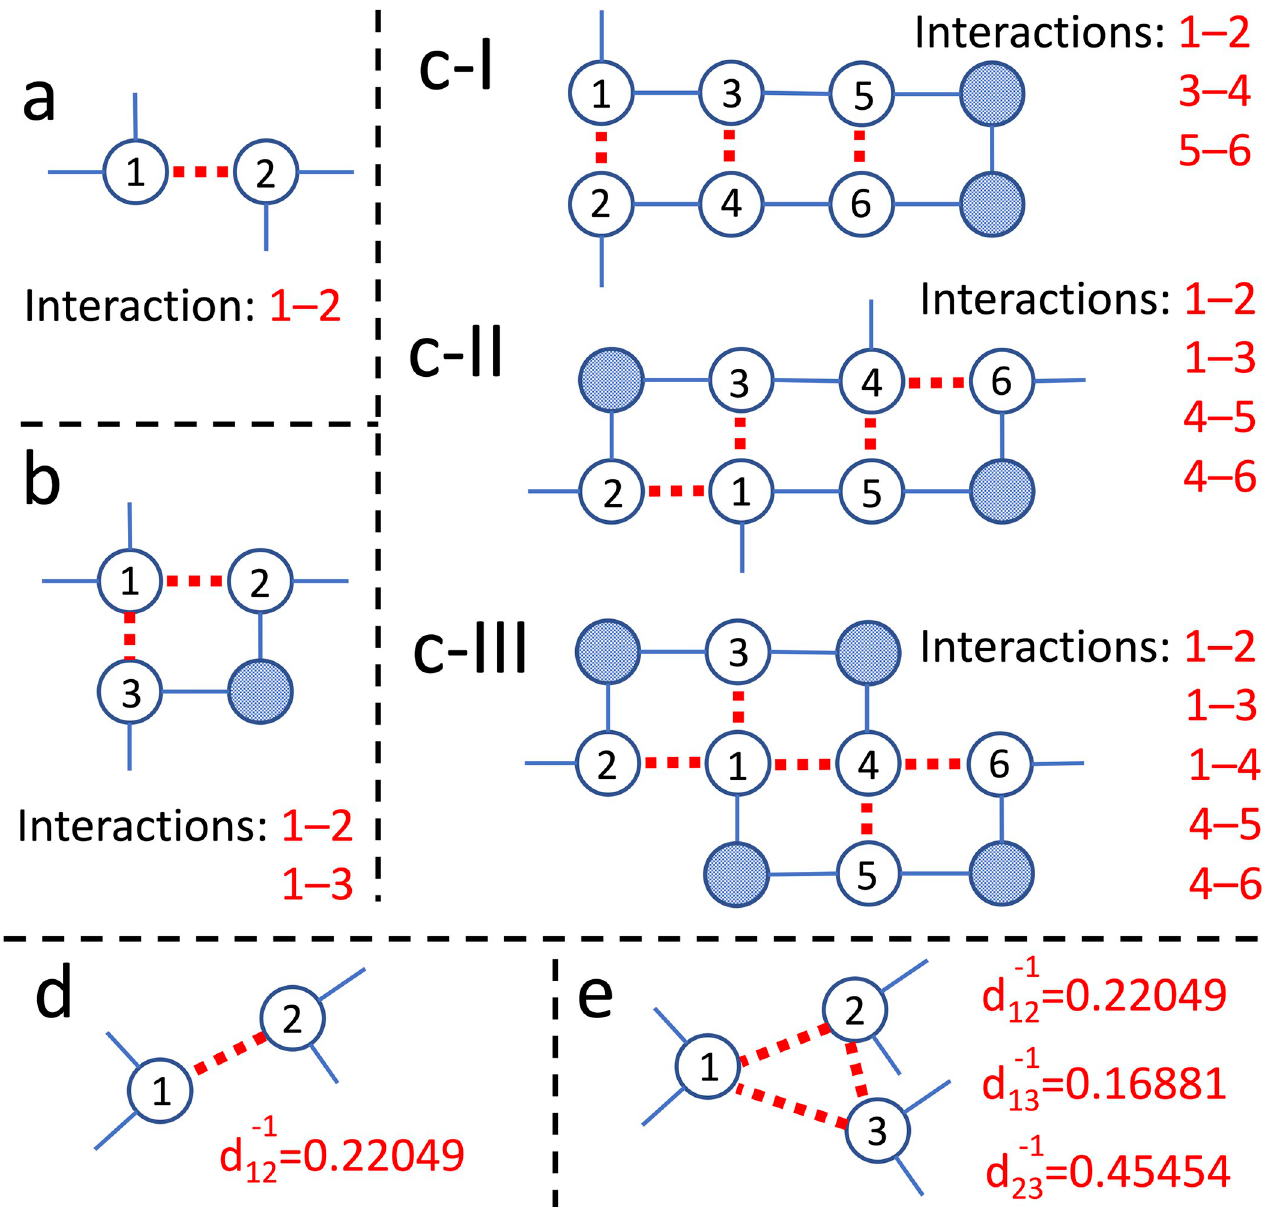
Fig 2. Schematic representations of protein models. SP model with: a) Two designable sites; b) Three designable sites; c) Six designable sites with I) three, II) four, and III) five pair-wise interactions. MR model with: d) Two designable sites; e) Three designable sites. The designable sites are shown as circles with numbers. The red dashed lines represent the interactions among the designable sites. In a–c) the pattern of interactions between the sites are provided for each structure. The checkered circles are non-interacting residues. In this study , there are no geometrical differences between residues , and all are being treated as is the corresponding distance reciprocal between designable sites i and j identical beads represented with circles . In d) and e) the d (cid:0) 1 ij